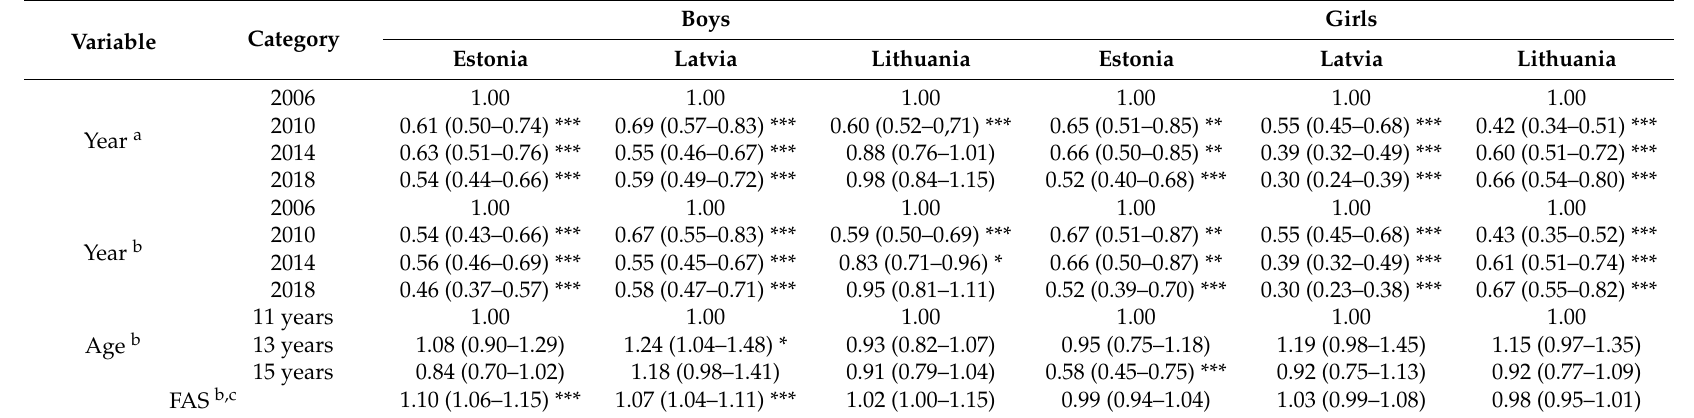
Table 5. Consumption of soft drinks daily by survey year, age group and family a ffl uence (odds ratios and 95% confidence intervals).